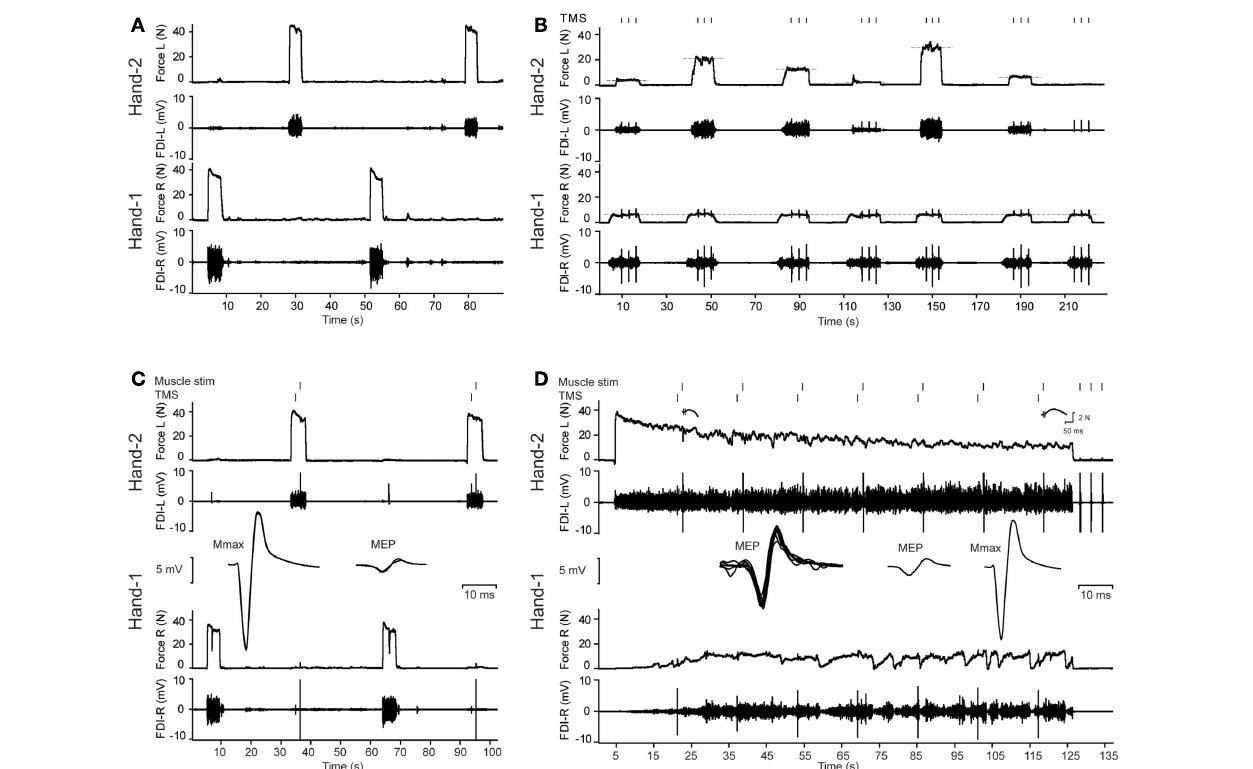
stimulation of Hand-2 andTMS of the motor cortex contralateral to Hand-1. Before the MVCs, the ulnar nerve of Hand-1 was stimulated to evoke maximal M -waves ( M max ). (C) Shows an overlay of five M max responses, followed by an overlay of three MEPs (recorded in the right hand) obtained during MVCs of the left hand. (D) Two-minute contraction with Hand-2. During the contractions, MEPs were evoked in Hand-1; an overlay of all MEPs during the fatigue test is presented together with the MEP during a brief contraction of the left hand and M max ( n = 5) obtained after the fatiguing task. Note the increase in associated activity in